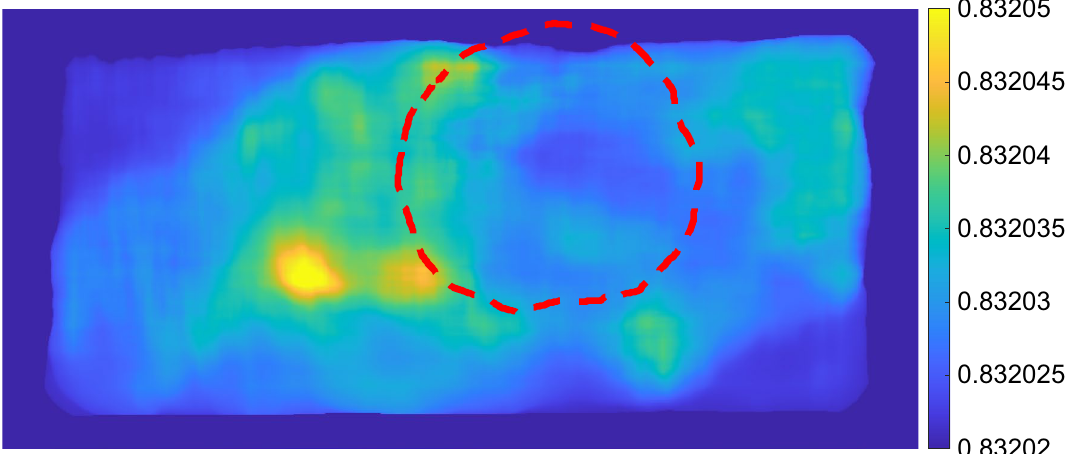
Figure 1. Example of chart based on the flow measure for the frequencies 0.02–0.08 Hz. Resection mask is shown with red dashed